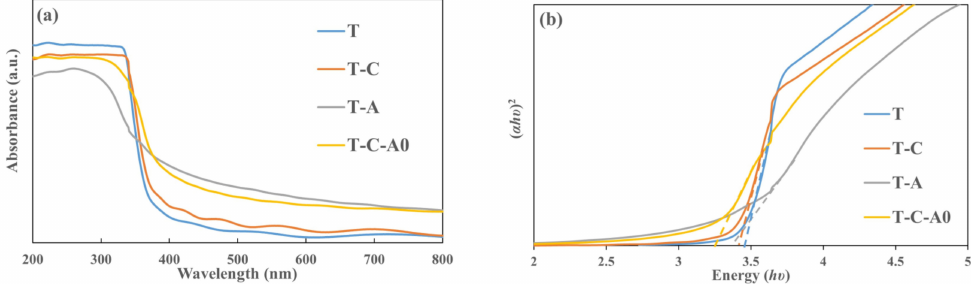
Figure 8. Optical properties of the T and T-composite film: ( a ) absorbance spectra and ( b ) ( α h υ ) 2 versus photon energy ( h υ ) plot of the prepared